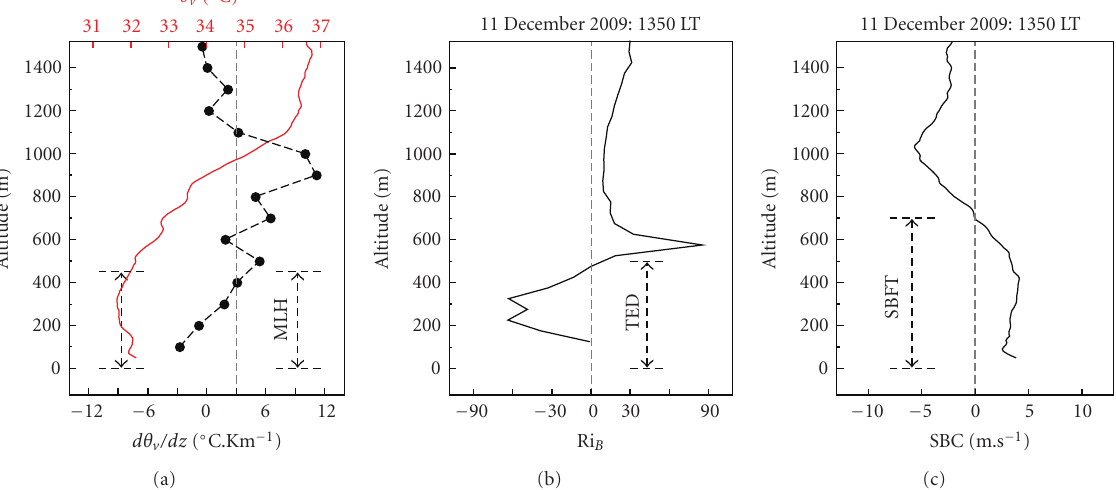
Figure 2: Vertical Profiles of (a) virtual potential temperature ( θ v ) and ( dθ v /dz ), (b) bulk Richardson number (Ri B ), and (c) sea breeze component (SBC) depicting three di ff erent techniques adopted for determination of mixed layer height (MLH), turbulent flow depth (TFD), and sea breeze flow thickness (SBFT), respectively. These layers are marked by arrows in